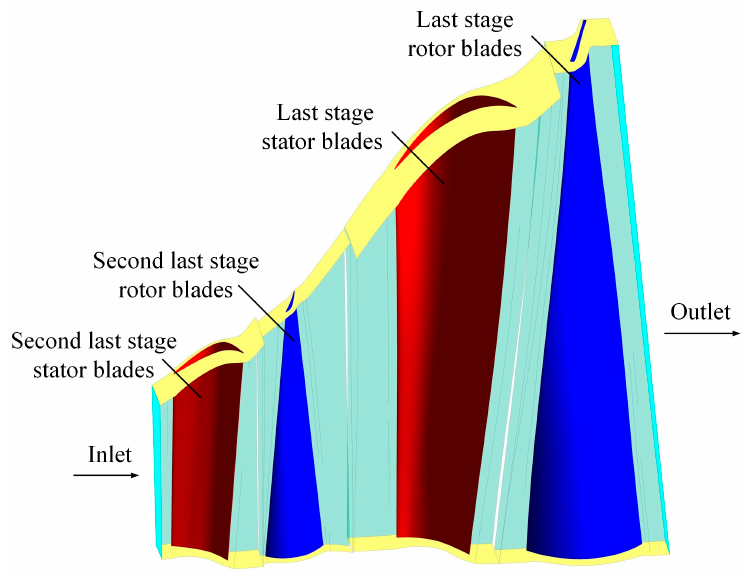
Figure 1. Last two stages of the single ‐ channel structure in the low ‐ pressure cylinder of a steam turbine.